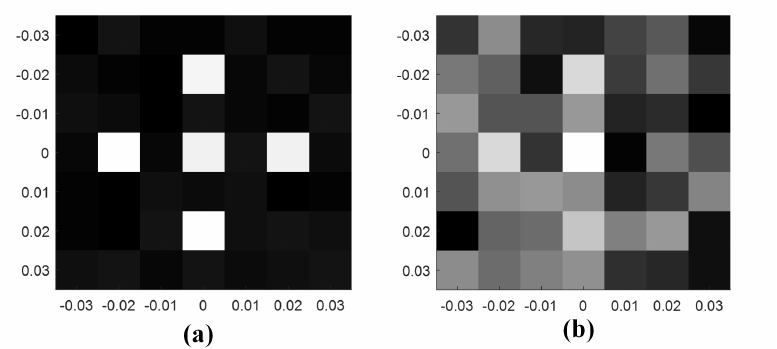
Figure 10. Comparison of the imaging results under the same experiment conditions; ( a ) Reconstructed image using the BMA; ( b ) Reconstructed image using the